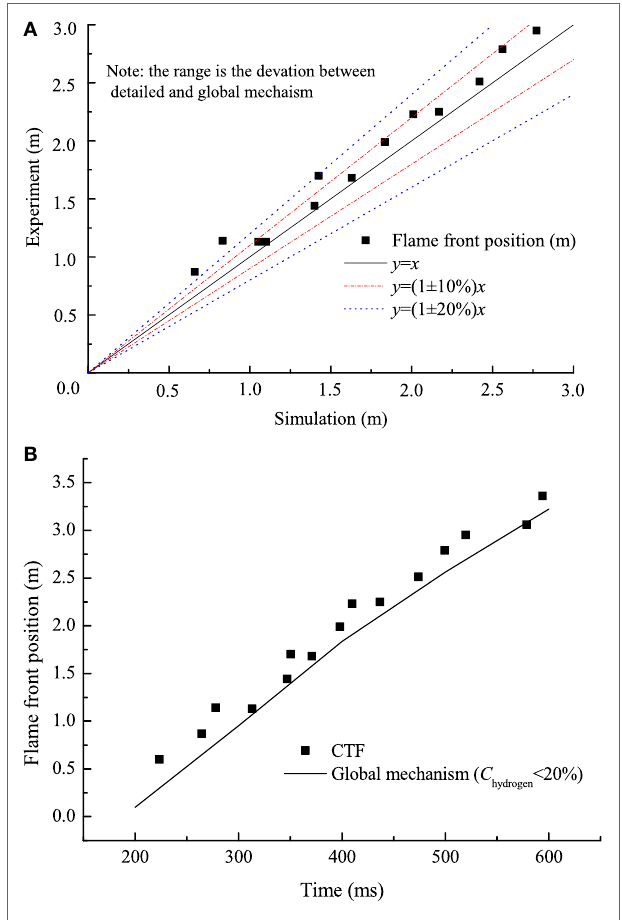
FIGURE 6 | (A) Comparison of flame front position between numerical and published data; (B) comparison of flame front position between updated kinetics and